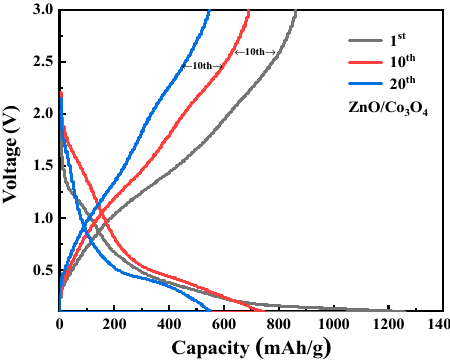
Figure 6. Galvanostatic charge/discharge curves of ZnO/Co 3 O 4 .